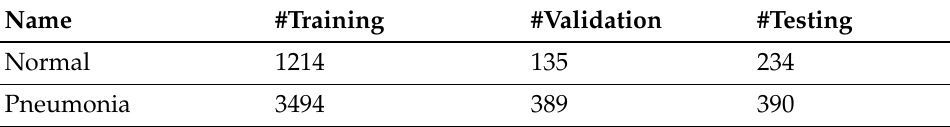
Table 5. Details of PneumoniaMNIST dataset.